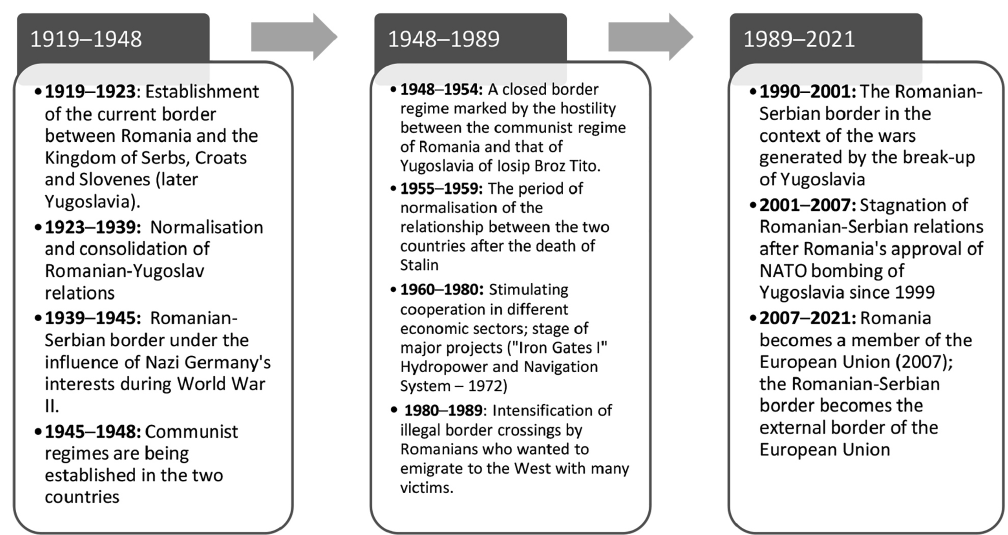
Fig. 5. The historical context of the Romanian-Serbian border in the period 1919–2021. Source: own